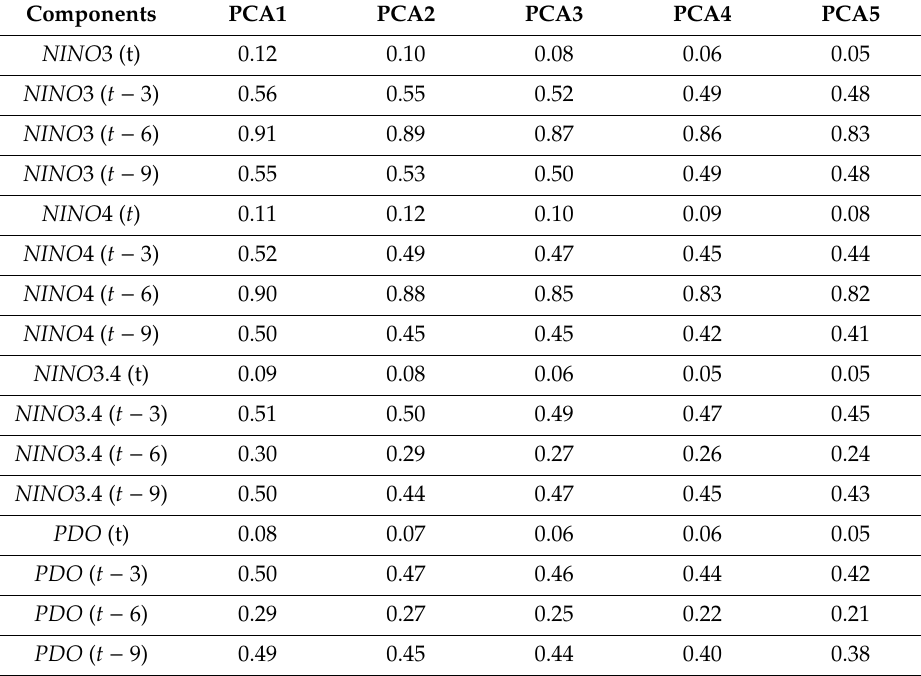
Table 4. Characteristics of main components based on Varex